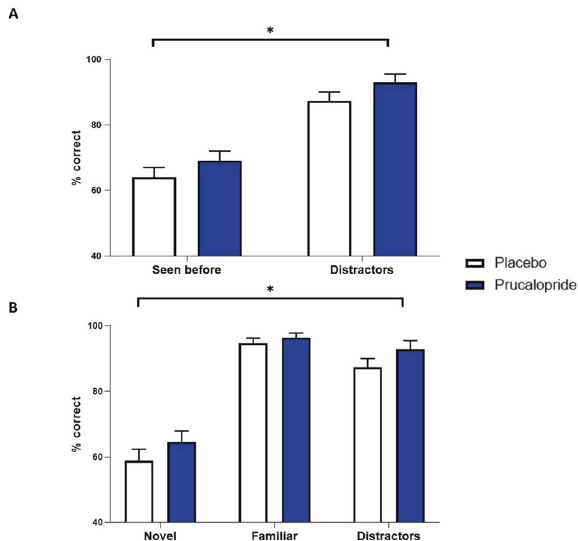
Fig. 2 Post-scan recall task results (percentage total correct at identifying image type) divided by group. White = placebo, blue = prucalopride. * p < 0.05, signifying a main effect of group on ANOVA both when comparing placebo vs. prucalopride for A seen before (novel + familiar) vs. distractors; B novel vs. familiar vs. distractors.